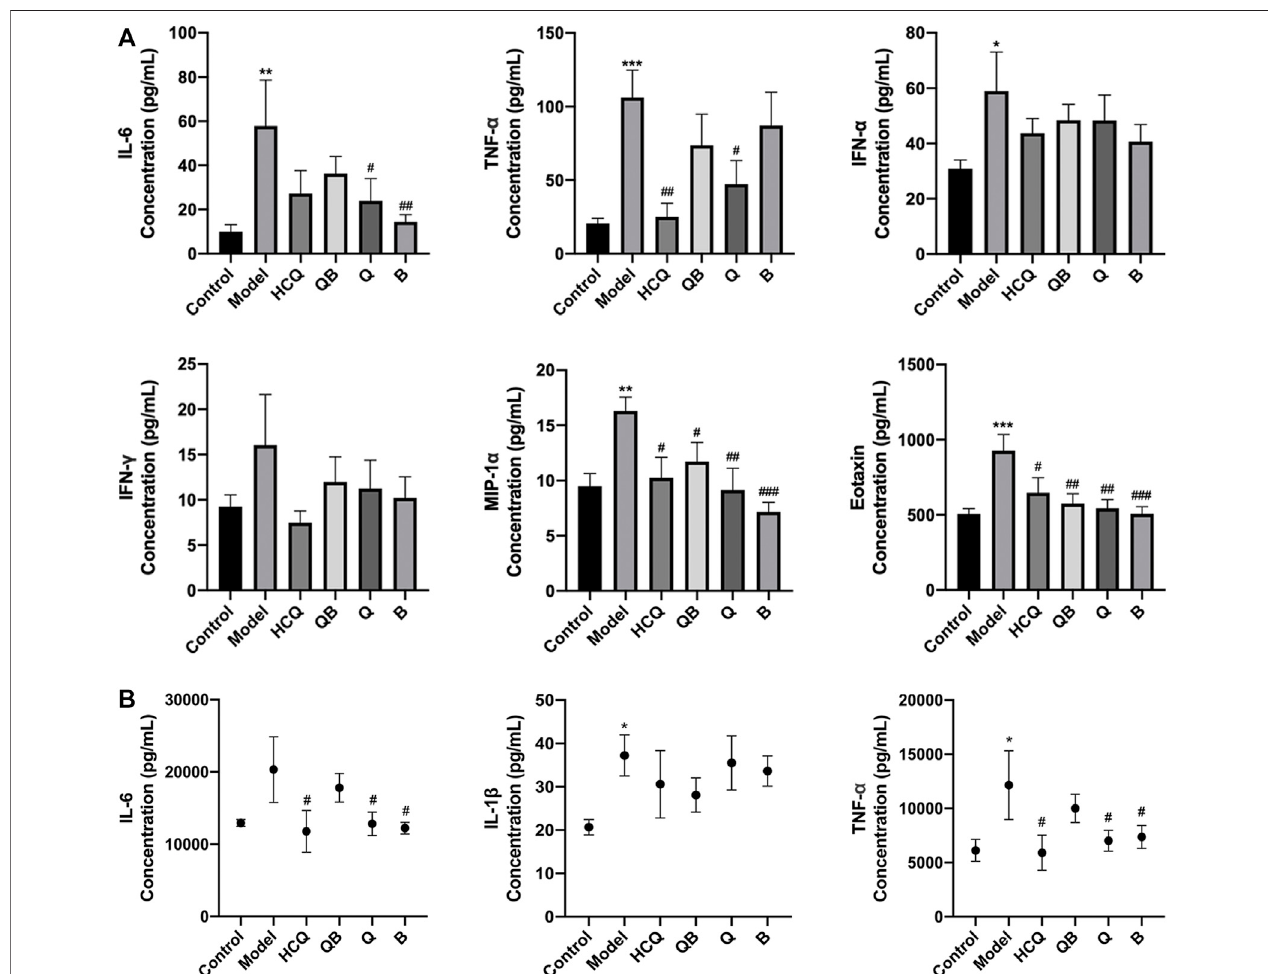
FIGURE 5 | Effect of Qinghao-Biejia on in fl ammatory cytokines in serum and kidney. (A) The level of interleukin-6 (IL-6), tumour necrosis factor alpha (TNF- α ), interferon alpha (IFN- α ), interferon gamma (IFN- γ ), macrophage in fl ammatory protein-1 alpha (MIP-1 α ), and eotaxin in serum. (B) The level of IL-6, interleukin-1 beta (IL- 1 β ), TNF- α , and IFN- γ in kidney. The data are expressed as the mean ± SEM. Model group compared with the control group, * p < 0.05, ** p < 0.01, *** p < 0.001; the remaining groups compared with the model group, # p < 0.05, ## p < 0.01, ### p < 0.001.